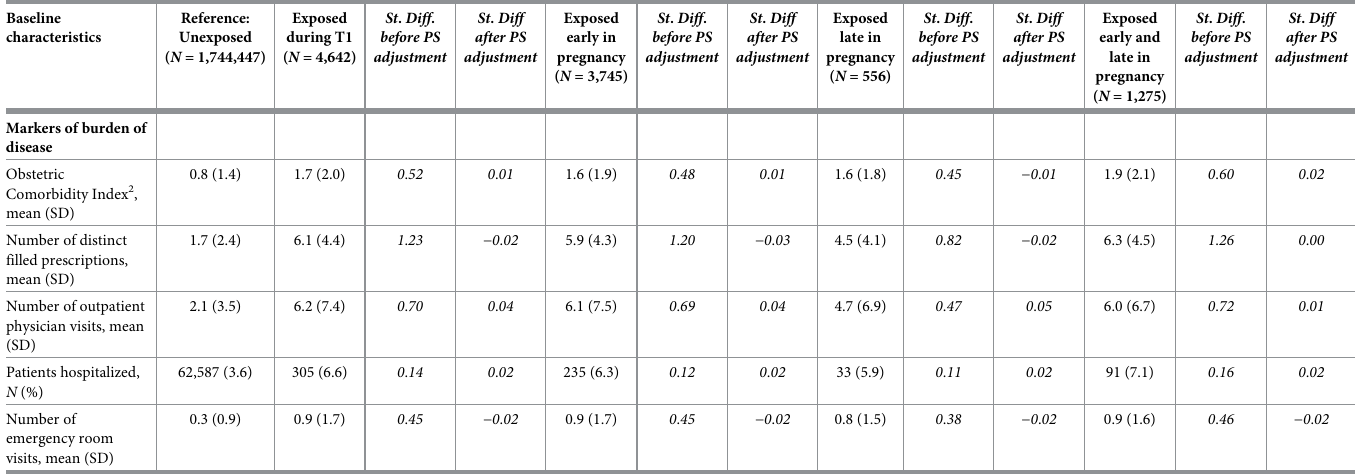
diac malformations, revealed an increased risk for conotruncal defects (RR, 1.99 [1.03–3.82], p = 0.04] (S6 Table), which persisted in analyses that were restricted to pregnant women that filled � 2 prescriptions, redefined the outcome using infant claims only, and with hdPS adjust- ment. Elevated but imprecisely estimated risks were also observed for left-sided defects and other cardiac defects. Elevated point estimates were observed for central nervous system defects, ear anomalies, and noncardiac vascular defects, albeit with wide CIs (S7 Table). Analy- ses based on tertiles of the first or the highest gabapentin prescribed daily dose filled during the specific exposure period of interest did not reveal dose-response relations for any of the examined outcomes (S8 Table). After accounting for potential differences in the probability of termination of malformed fetuses among exposed and unexposed women, the range of plausi- ble RRs for major overall malformations estimated for pregnancies exposed to gabapentin dur- ing T1 was 1.09 to 1.17 (S5 Fig). Finally, quantification of the bias associated with potential residual imbalances in maternal smoking between exposed and unexposed pregnancies revealed that adjusted RRs of preterm birth, SGA, and preeclampsia for gabapentin